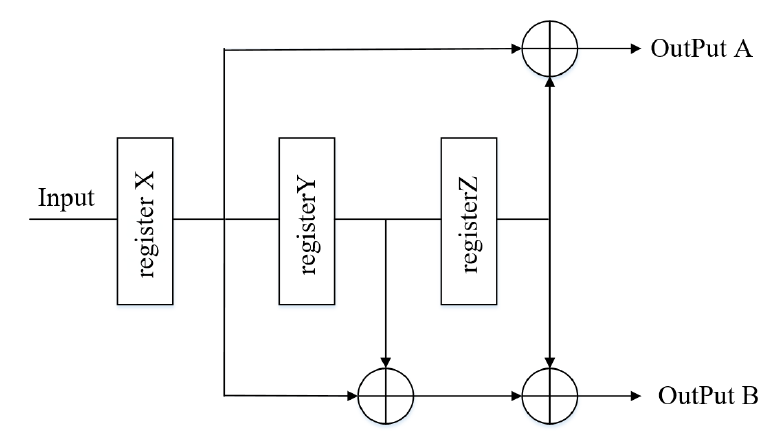
Figure 2. Method of the convolutional code